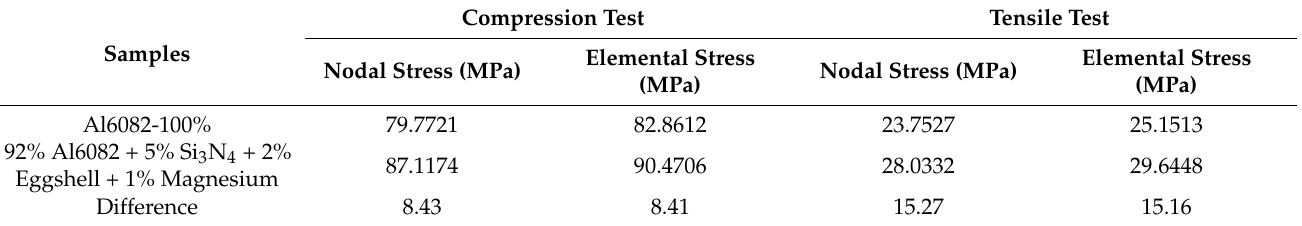
Table 16. Simulation outcomes of nodal and elemental stress on Al6082 and Al + ES + Mg